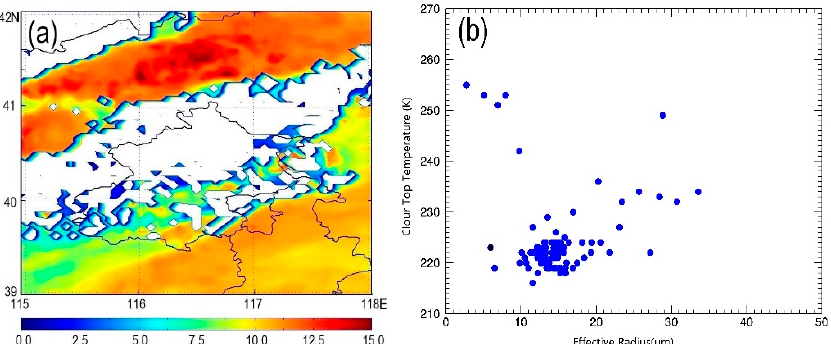
Figure 3. Time series variation of BTs in channels 9 (7.0 µ m) and 14 (11.2 µ m) transecting the main core of the hailstorm for the analyzed case study on 1 July 2021.